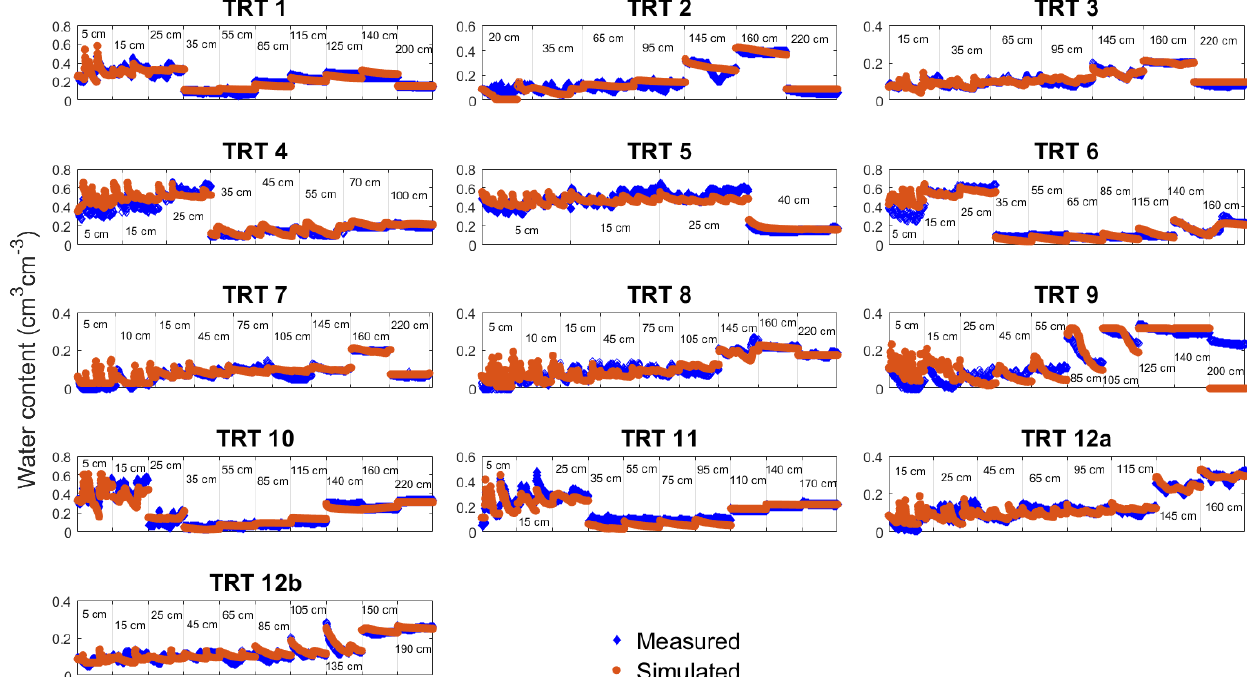
Figure 3. Comparison between the measured and simulated water contents at different depths within each of 13 treatment covers for the days when temperature is greater than 0 ◦ C. Typical depths at which the water content measurements are recorded vary from 5 to 200cm within the treatment covers.